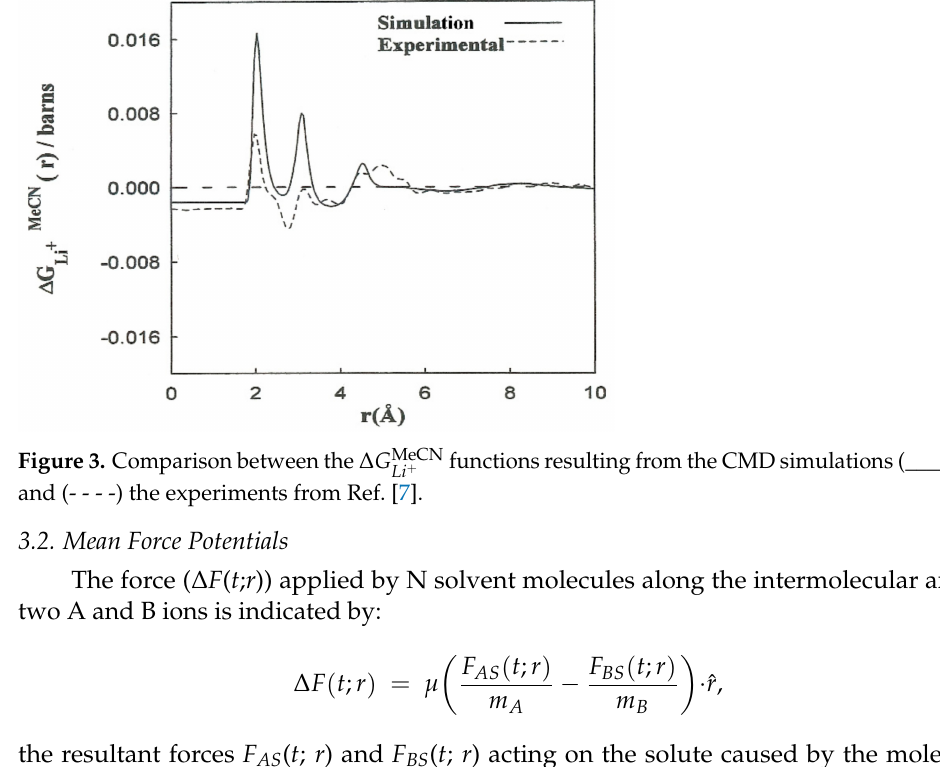
functions resulting from the CMD simulations (________) Li +